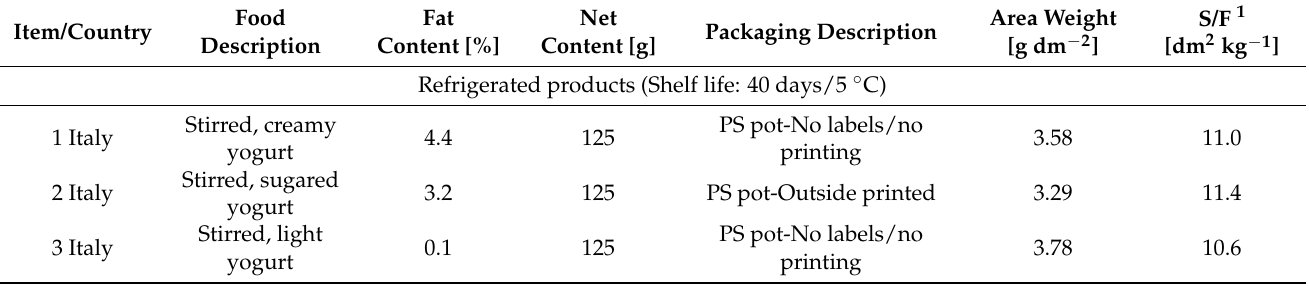
Table 2. Description and main characteristics of the investigated products (food and